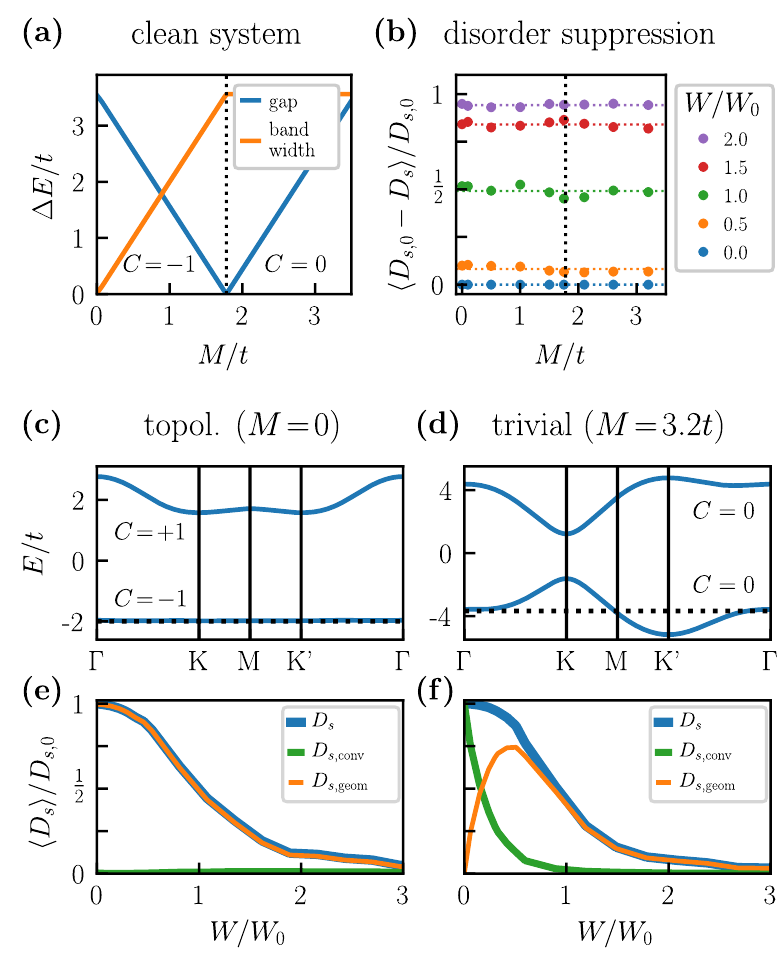
Figure 2: Disorder-induced suppression of the superfluid weight in the extended Kane-Mele model. (a) Evolution of the energy gap and the bandwidth of the lower band as a function of M . C is the Chern number of the lower spin-up band. (b) D as a function of M for different values of W / W black line indicates the topological transition in the clean system. (c), (d) Energy bands of the clean systems along high-symmetry lines of the Brillouin zone for M values corresponding to topologically distinct cases. The dotted black lines indicate the Fermi level corresponding to ¯ ν = 1 / 2. (e), (f) 〈 D ¯ ν = 1 /